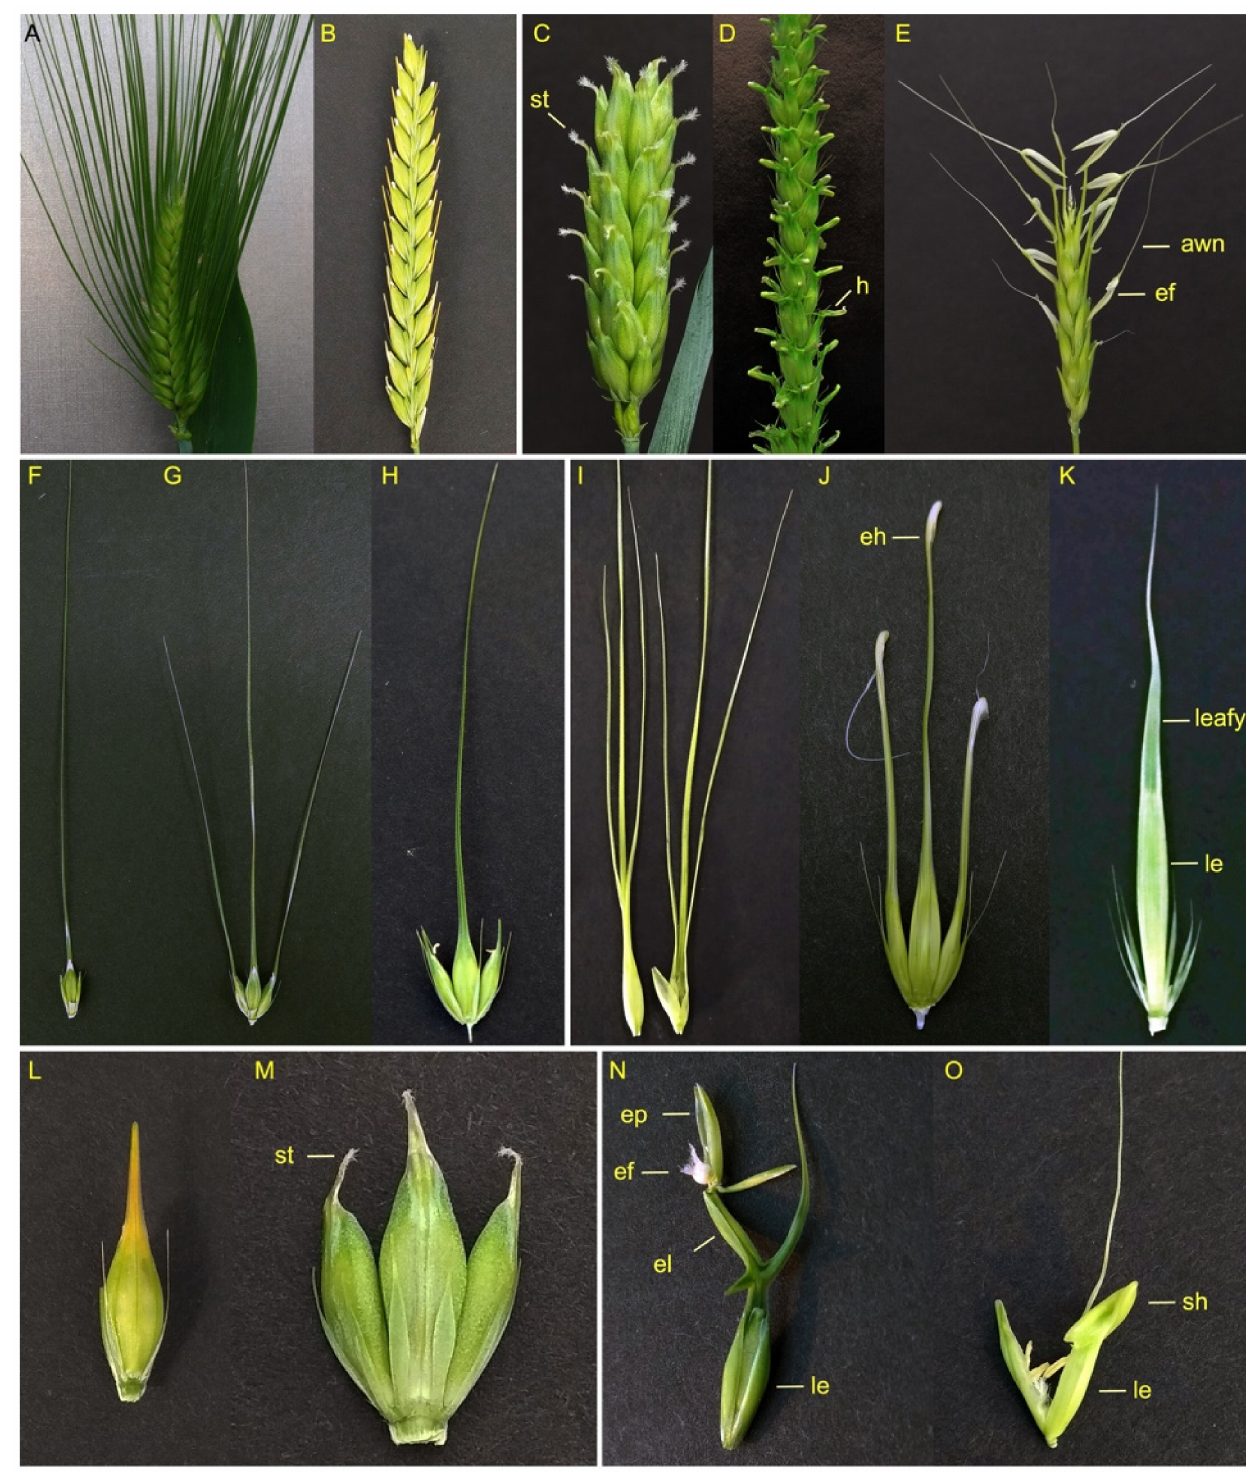
Figure 2. Morphological diversity of awns in barley cultivars and mutants. ( A ), 6-rowed spike with long awns. ( B ), awnless 2-rowed spike. ( C ), 6-rowed spike with stigma-like short, crooked awns. ( D ), Hooded spike. ( E ), Hooded spike with long awns. ( F , G ), 2-rowed and 6-rowed spikes with long awns. ( H ), 6-rowed spike having long awns on the central spikelet and awnless lateral spikelets. ( I ), Front- and side-views of a triple awn. ( J ), 6-rowed spikelets with elevated hoods. ( K ), spikelet with leafy awn. ( L ), awnless spikelet. ( M ), 6-rowed spikelets with stigma-like short, crooked awns. ( N ), hooded floret with an extra floret. ( O ), subjacent hooded floret. st, stigma-like short, crooked awn; h, hooded awn; ef, extra floret; eh, elevated hooded; leafy, leafy awn; le, lemma; ep, extra palea, el, extra